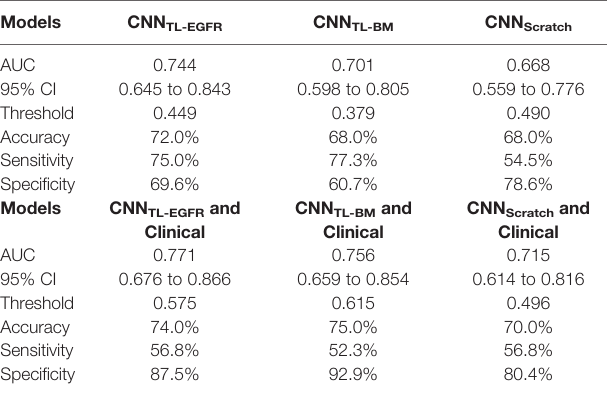
TABLE 3 | Performance of different PFS prediction models in the validation group.